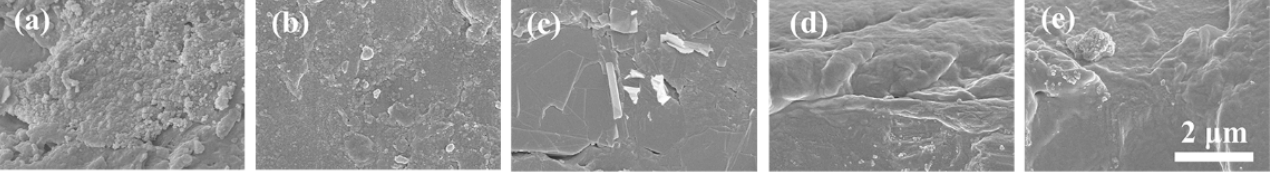
Figure 5. EDX mapping results of ( a ) 80Zn and ( b ) 2PANI-67Zn. 3.3. Effect of Conductive Additives on the Anti-Corrosion Performance of Coating Samples Based on the prominent conductivities of the additives and the rough surface mor- phology of the modified samples, we further studied the effect of the conductive additives on the anti-corrosion performance. The accelerated corrosion assay results (Figure 6b–d,l) show that t he delamination and corrosion around the scribe of all of the CB-modified samples and 2PANI-67Zn were in grade 1 (very slight), and the mean overall width of the delamination was less than 0.8 mm according to ISO 4828-8, showing even better corro- sion resistance than that of the control sample, Zn80 (grade 2, slight, width = 1.0 mm) . There was slight corrosion (grade 2) throughout the inscribed area after 500 h of exposure to the ambient salt spray for the CG- and PANI-modified samples. For the MWNCT series, the zinc dust was largely consumed to produce a number of white corrosion products after only 200 h of the salt spray test; thus, the corrosion widths of the MWNCT series were not measured. To better confirm the corrosion products of the MWCNT-modified coatings after the salt spray test, Raman spectroscopic investigation was conducted. As shown in Figure 6n, the peaks at 259.03 and 389.51 cm − 1 , which correspond to the Zn–Cl stretching vibration and Zn–O stretching, respectively, were both identified as the char- acteristic peaks of ZnCl 2 ·4Zn(OH) 2 ·H 2 O. Additionally, the peak of 1069.69 cm − 1 was at- tributed to the resin component of the coating [35,36]. Together with the type of additives, the conductive additive concentration has also been proven to have a great influence on the anti-corrosion performance. Each additive had its own optimum content. 2CB-67Zn was considered the best among the CB-modified series based on the narrowest creepage (about 0.4 mm) and the absence of rust spots or blisters, and the same additive dosage was also applicable for the PANI series, suggesting that an additive content of 2 wt.% may be optimal for CB and PANI series. On one hand,